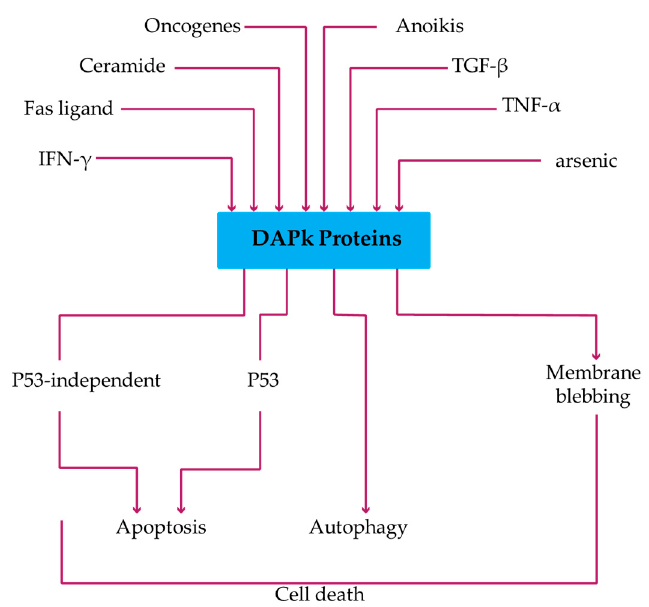
Figure 2. Activation of different DAPk signaling cascade by different stimuli. Based on the signal input and cell context, the DAPk family of genes play a crucial role is deciding the outcome of whether a cell survives or undergoes apoptosis. Activated DAPk proteins may initiate p53-dependent or independent apoptosis or mediate an autophagic programmed cell death [39].